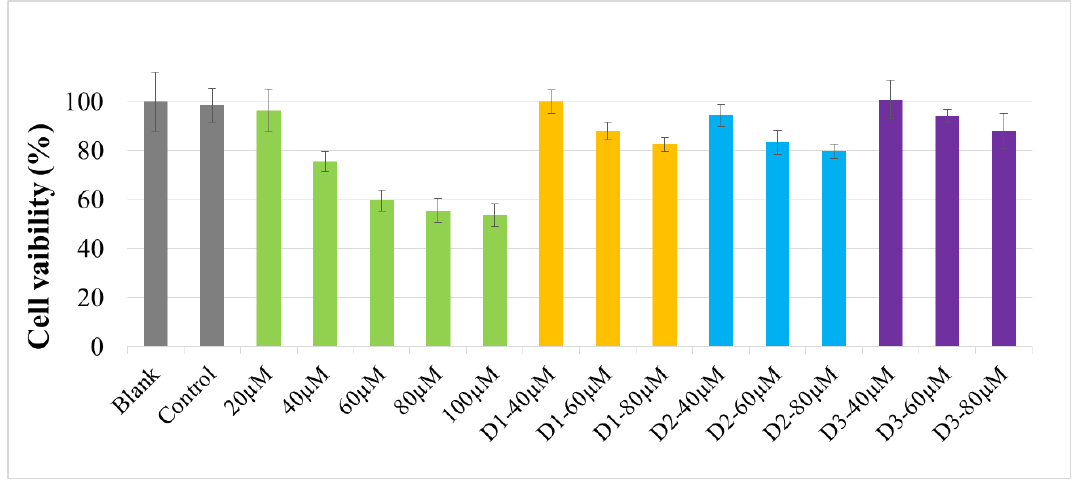
Figure 6. Cell viability of RSV and RSV transfersomes (D1–20(W), D2–12(W), and D3–80(W) groups). The cell viability of B16–F10 cells was analyzed by MTT assay after 24 h treatment. The values are means ± SD.